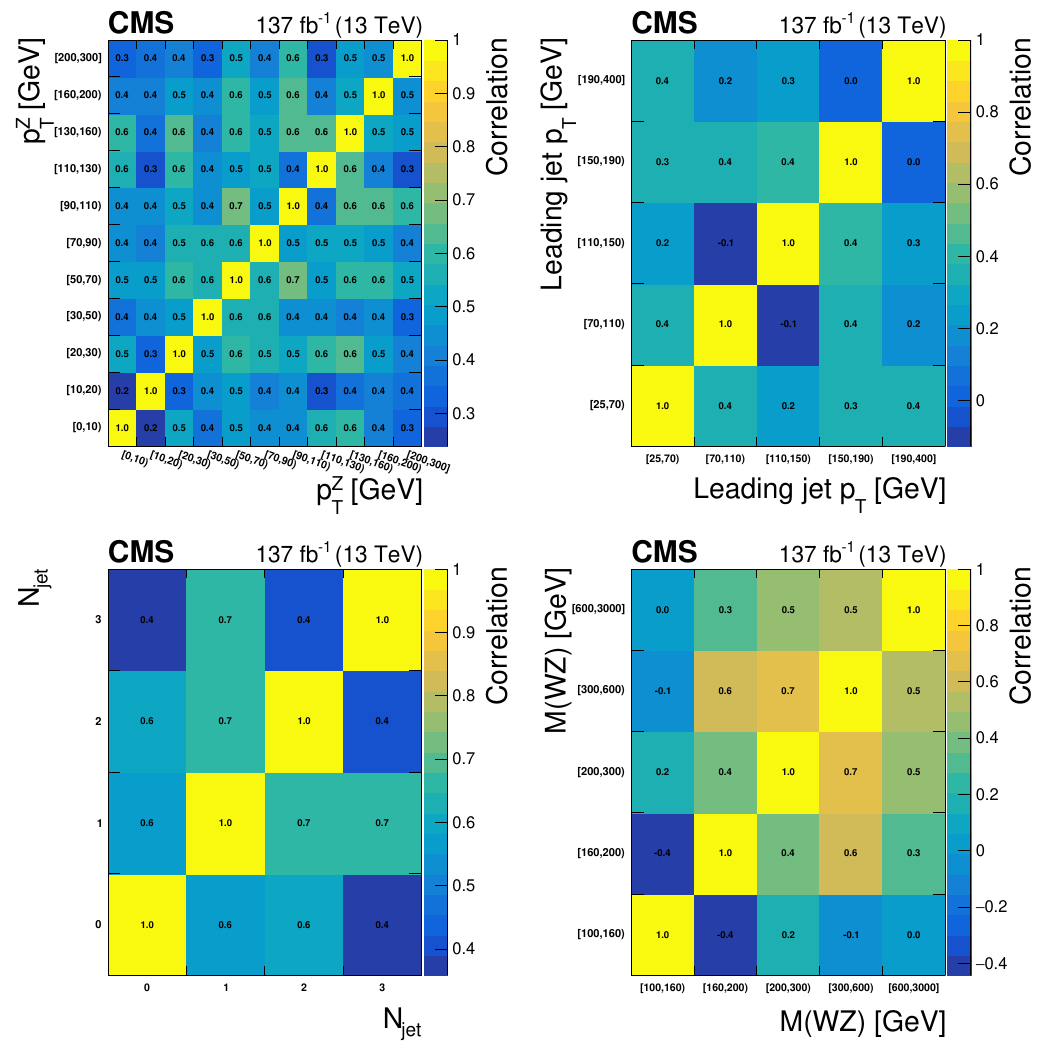
Figure 15 . Correlation matrices for the unfolded results obtained using NNLO bias, area con- straint, and no additional regularization term for several variables: the p (top left), the p value of the leading jet in the event (top right), the jet multiplicity (bottom left) T and the M (WZ) variable (bottom